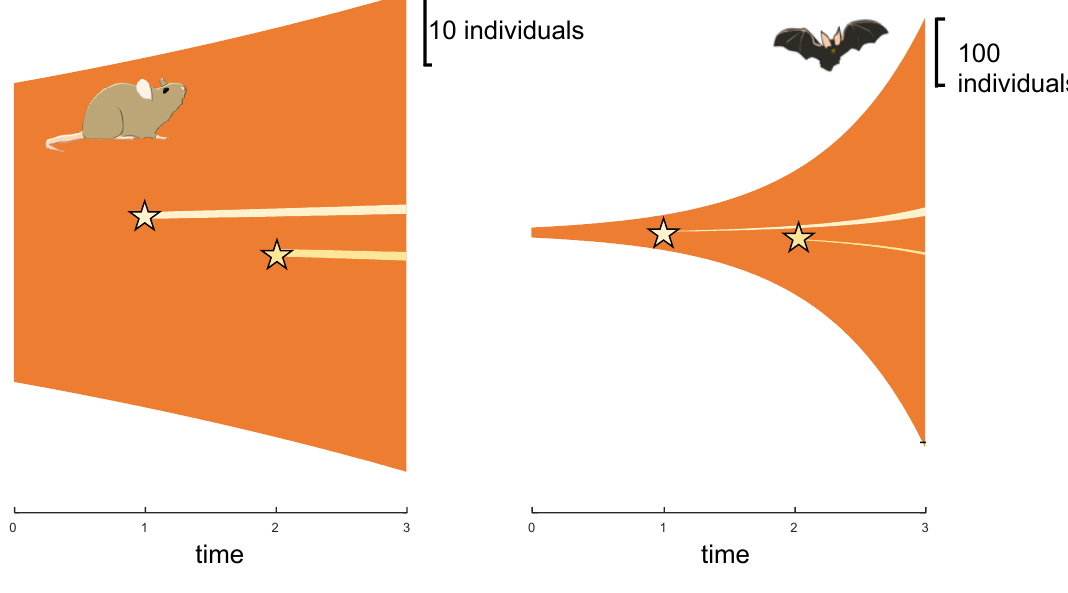
Figure 1 – A visualization of why the bat, with its threefold growth rate, is penalized more for a delay in placing offspring into a growing population. For purely aesthetic reasons, population growth is depicted over continuous time ( r = ln ( λ ) ). Values of r correspond to λ values given in Table 1. Populations are assumed to consist of slow senescers (Table 1) and stars depict the placement of one offspring at time t = 1 or t = 2 into a growing population. Both species consist of 50 individuals at time t = 1 (shown at a different scale as indicated, to fit the entire growth into picture, as bats, with their higher survival, increase their numbers much faster than mice). For both species, the lineage (pale stripes) that starts with an offspring placed into the population at t = 2 is thinner than the lineage that had its start at t = 1 , but this difference is much more marked if population growth is (b) fast than if it is (a) slow. In (b) both stripes appear narrow, because the vertical scale has to differ between (a) and (b) to allow the entire bat population to be